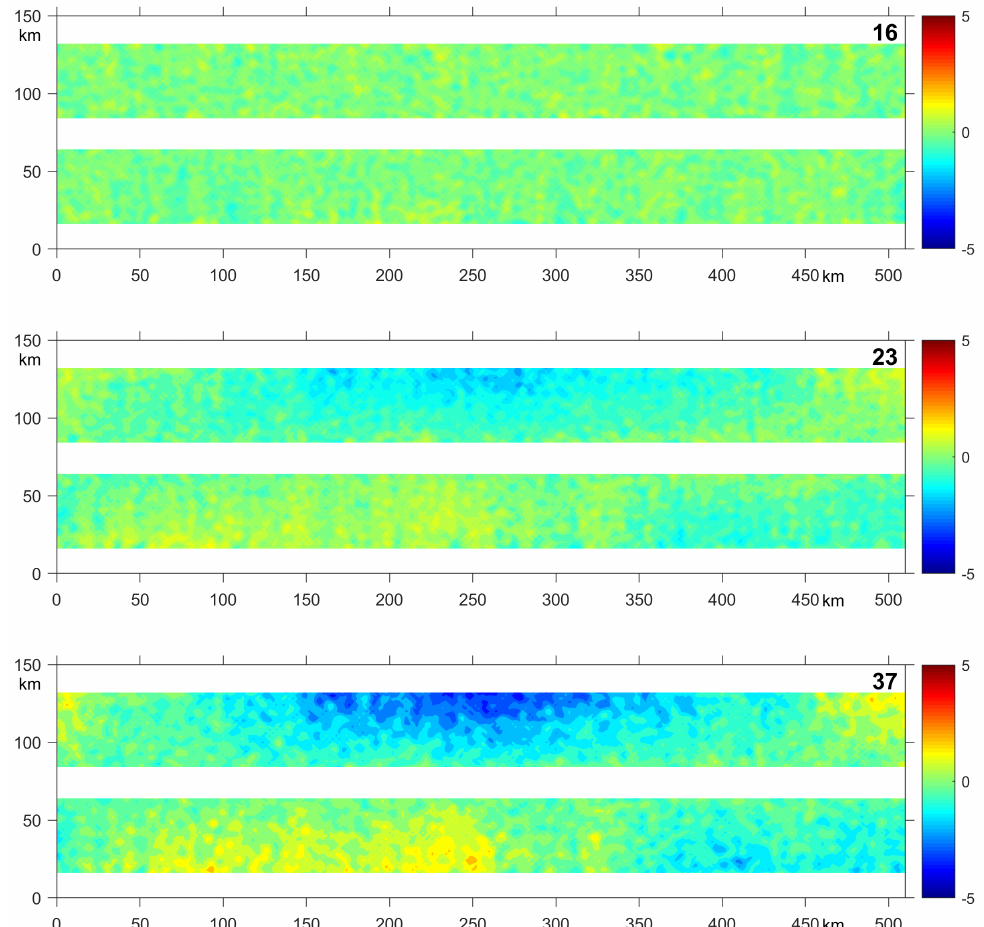
Figure 4. The error fields e ( x , y ) within the swath region obtained after assimilating the ensemble member in Figure 1 using the exact square root of the inverse covariance ( top ), its block-diagonal approximation ( middle ), and the diagonal approximation obtained from n samples of the error fields produced by the SWOT simulator ( bottom ). Relative deviations (swath-averaged, in %) from the true SSH field are shown in the upper right corners. The color bars are in